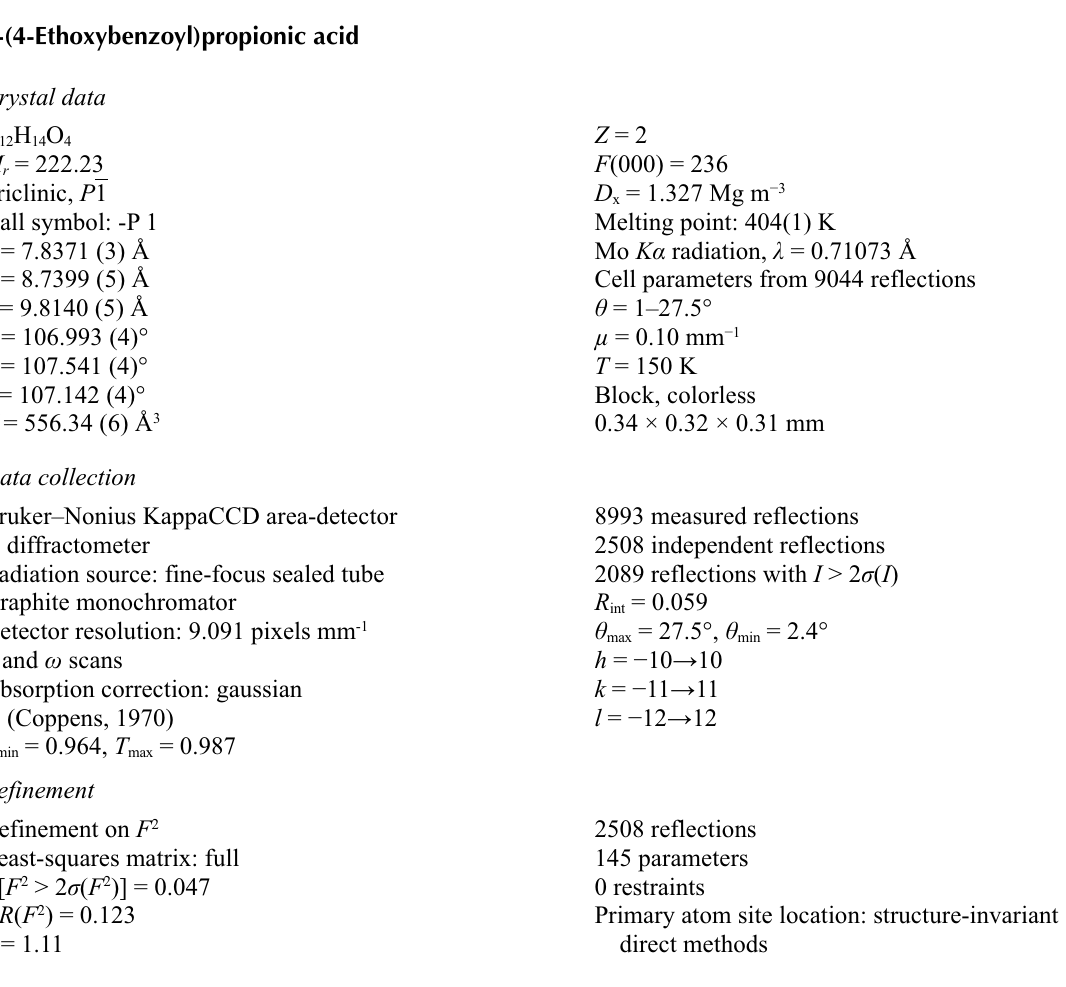
The formation of the title